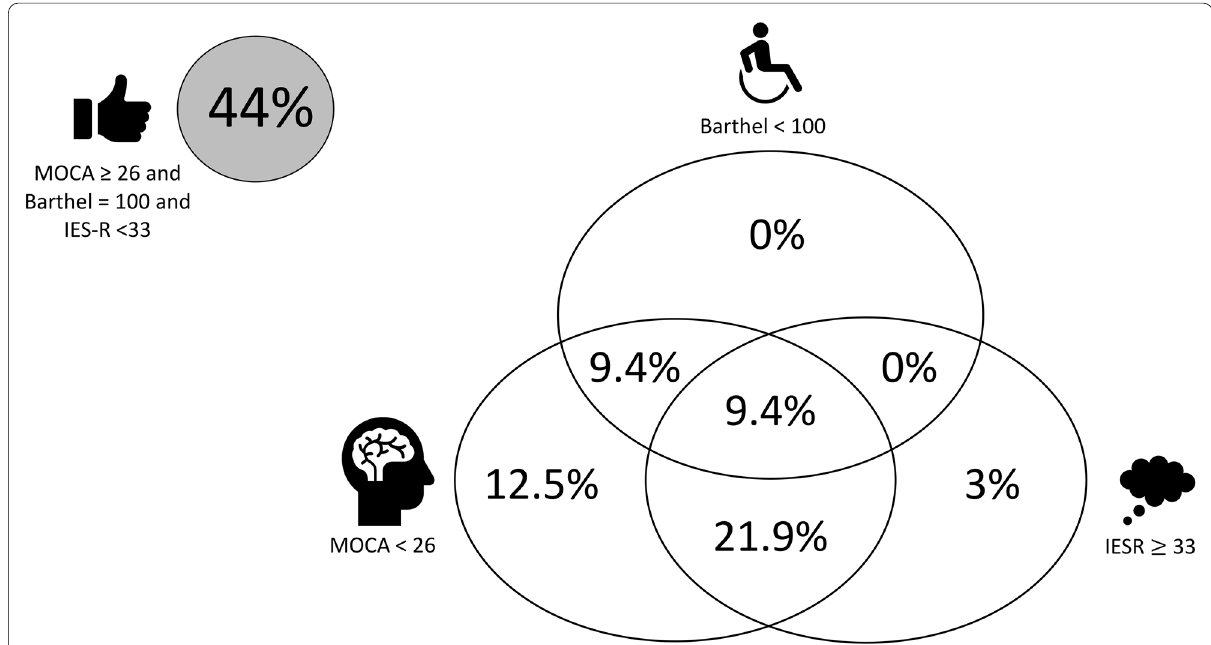
Fig. 3 Proportion of patients experiencing none (grey circle), one or a combination (white circles) of the three components of the post‑intensive care syndrome (PICS), analyzed using Barthel Index, MoCA and IES‑R (as defined in “Methods”)